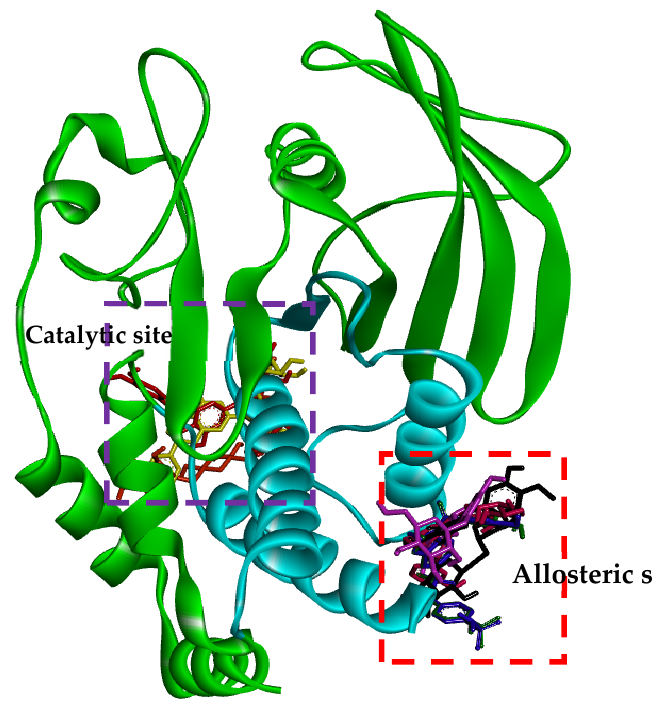
Figure 4. Molecular docking of PTP1B inhibition by compounds (compound 23 , compound 2 , hesperidin, neohesperidin, hesperetin 7- O -glucoside, hesperetin 5- O -glucoside and hesperetin). The tested compounds (compound 23 , compound 2 , hesperidin, neohesperidin, hesperetin 7- O -glucoside, hesperetin 5- O -glucoside and hesperetin) are represented by orange, blue, yellow, red, lavender, purple and green colored structures, respectively.